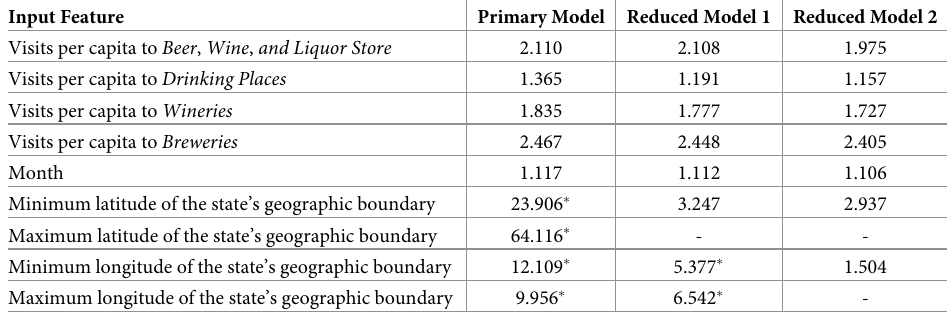
Table 2. VIF values of the variables in three MLR